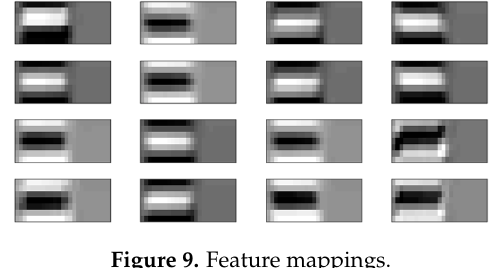
Figure 9. Feature mappings.